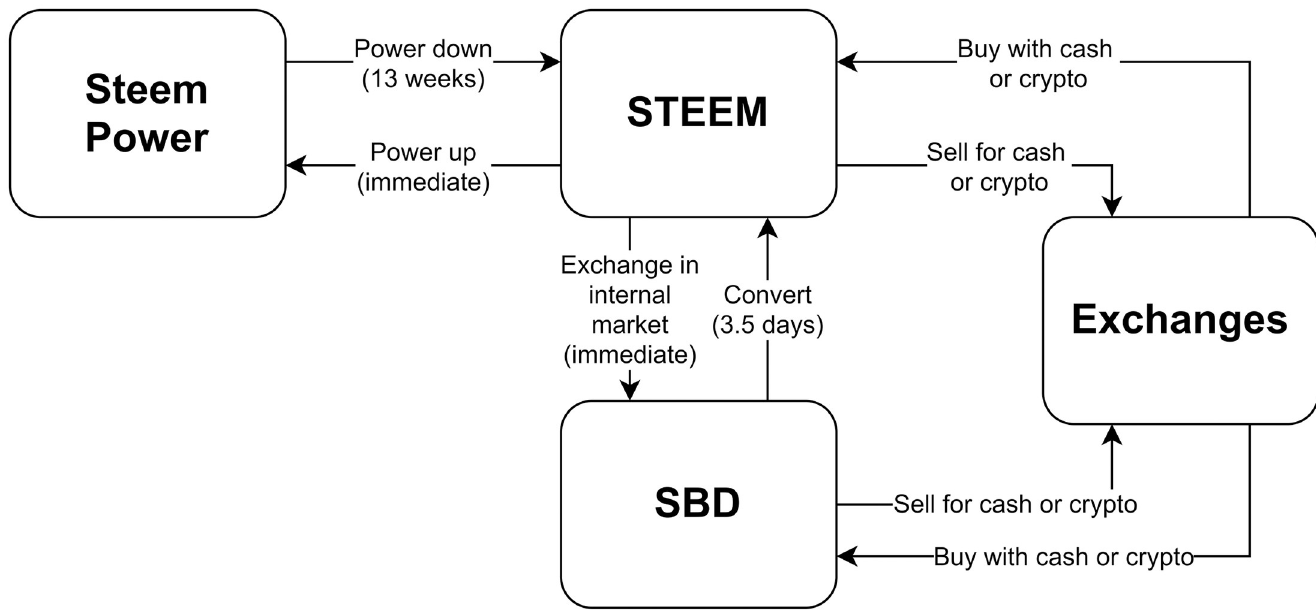
Fig 1. Tokens and conversion operations. Main currencies (rounded rectangles) in Steemit and possible conversion operations, are depicted as arrows. For each conversion or exchange operation, we report the type of the operation and temporal constraints, when available. In fact, many operations are instantaneous, while some others require more